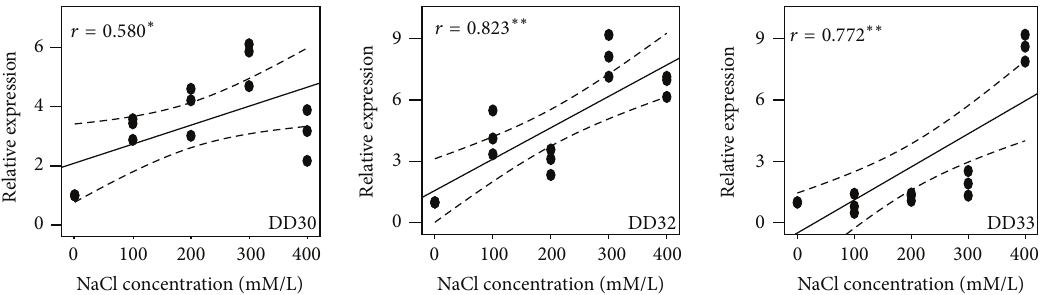
Figure 2: Expression patterns of 18 differentially expressed transcripts detected by qPCR between the control and NaCl-treated samples. The NaCl concentration is shown on the 𝑥 -axis and the relative expression (fold change) is shown on the 𝑦 -axis. Relative expressions of each transcript at one NaCl concentration represent the three independent experimental replicates. Fit lines show the correlation between the gene expression patterns of the differentially displayed transcripts and the NaCl concentrations. Dashed lines indicate 95% confidence intervals. Pearson correlation coefficients ( 𝑟 ) are shown. ∗∗ and ∗ indicate that the correlations are significant at the 0.01 and 0.05 levels,